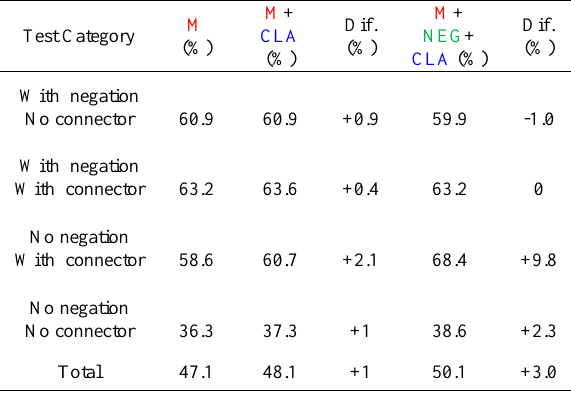
Table 4. Obtained results for subtree kernel method with combination of negation and clause related used feature sets in terms of f-measure.